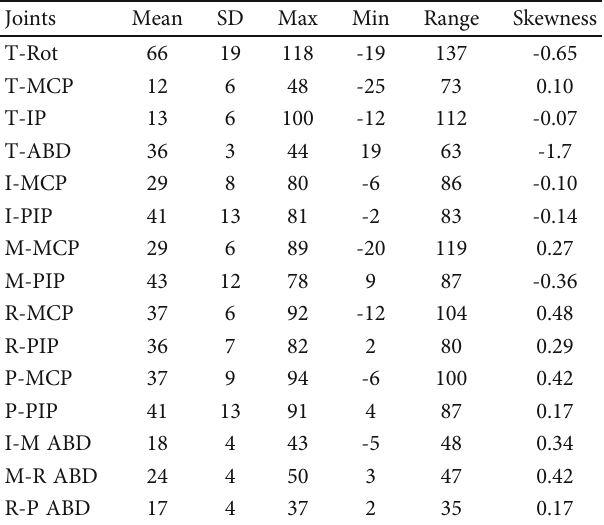
Figure 1: The grasped objects, acceptable range, Cyberglove calibration, and recording platform. Table 4: Basic statistics of the joint angle for all